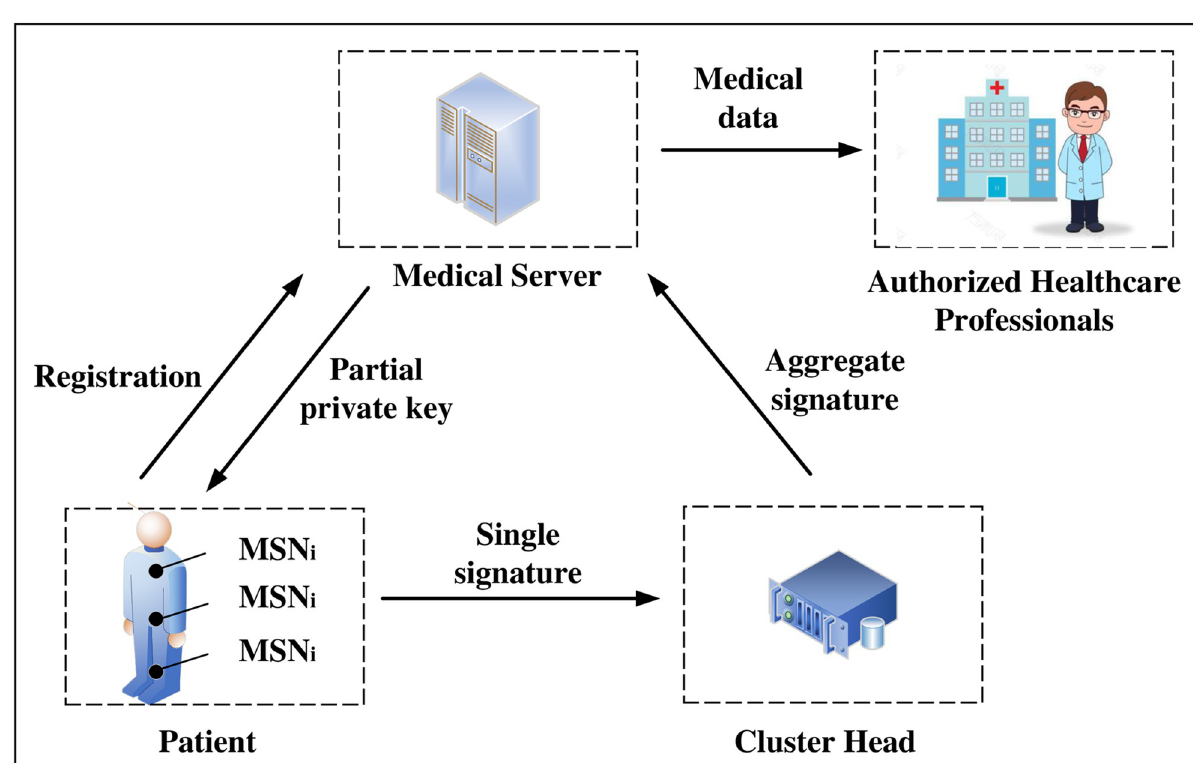
Fig 1. System model for